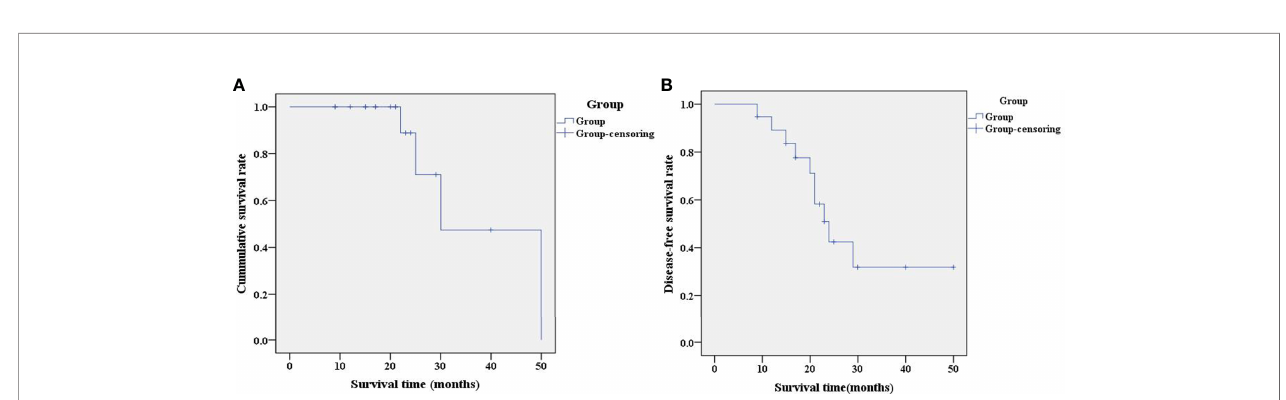
FIGURE 2 | Analysis of overall prognosis by survival curve. (A) Survival curve of 19 pediatric patients with HB; (B) Disease-free survival curve of 19 pediatric patients with HB. Group-censoring represents the cases that did not survive. HB,